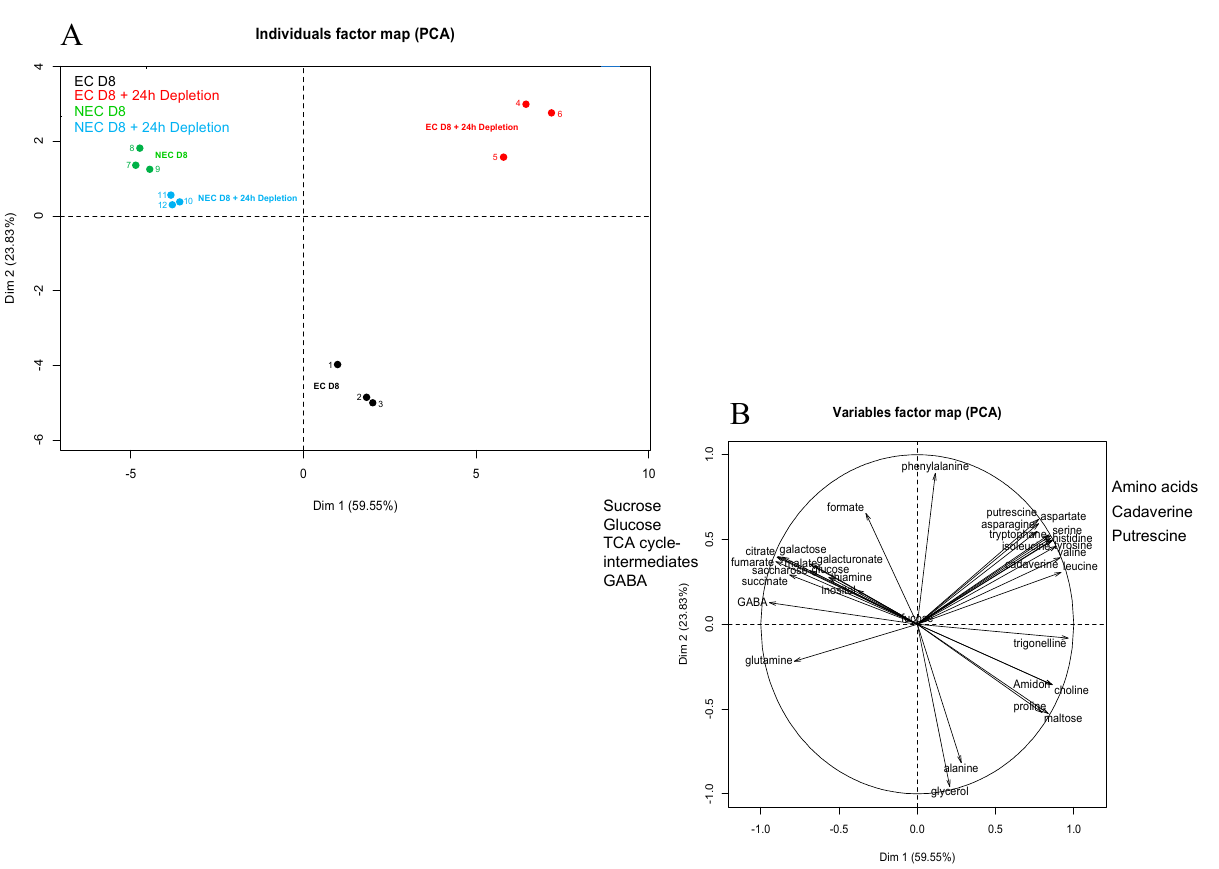
Figure 9. Principal component analysis (PCA) of measured cellular metabolites in embryogenic cells (EC) and non-embryogenic cells (NEC) grown under two conditions: 8 days of culture (D8) and 8 days of culture followed by 24 h of depletion (D8 + 24 h). ( A ) Individual map. Black-EC at D8; Red-EC at D8 plus 24 h depletion; Green-NEC at D8; Blue-NEC at D8 plus 24 h depletion ( B ) Correlation circles. The overall data of metabolite measurements were used, except glutamate, whose quantitation turned out to be impossible in the non-embryogenic cells. The soluble metabolites were quantified by 1 H NMR, while starch was determined by an enzymatic method. Metabolite quantitation was performed on cells from three independent biological replicates. The EC at D8 were characterized by relatively high concentrations of glycerol and alanine, while those at D8 + 24 h depletion presented high concentrations of free amino acids and polyamines (cadaverine and putrescine) (Figure 10). At D8 + 24 h depletion, the NEC maintained higher concentrations of glucose and Krebs cycle intermediates (citrate, succinate, fumarate, malate, γ -aminobutyric acid, GABA), when compared to the EC under the same condition (Figures 9B and S6). In EC, the 24 h depletion triggered a strong decrease of intracellular starch and sucrose concentrations, as well as moderate ones of succinate and malate. However, the concentrations of these metabolites were higher in NEC than in EC even after 24 h depletion: glucose > 6-fold; sucrose > 20-fold; succinate > 7-fold and malate > 20-fold (Figures 10 and